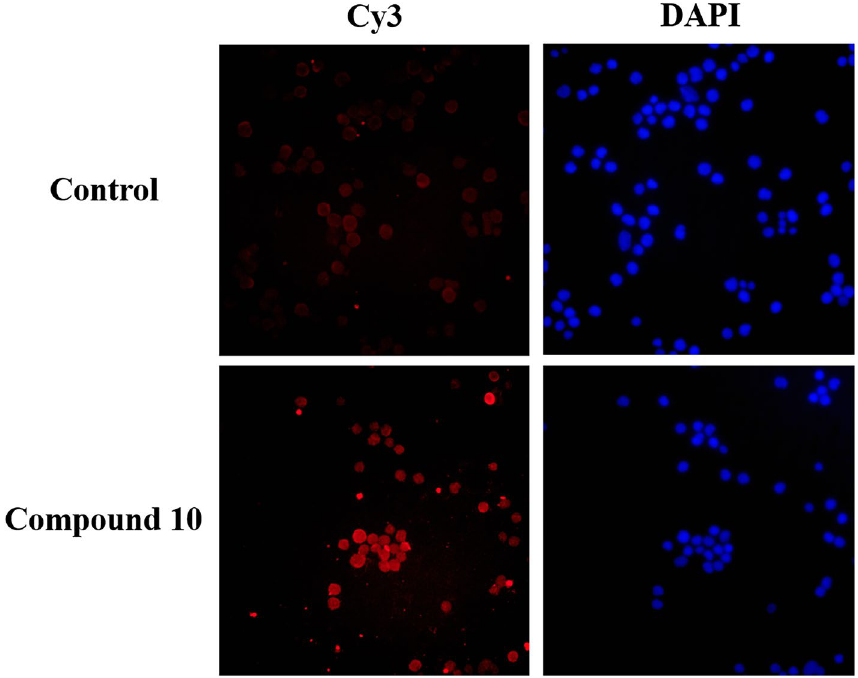
Figure 6. Sf9 cells stained with Cy3-dUTP after treatment compound 10 (15 μM) for 24 h.